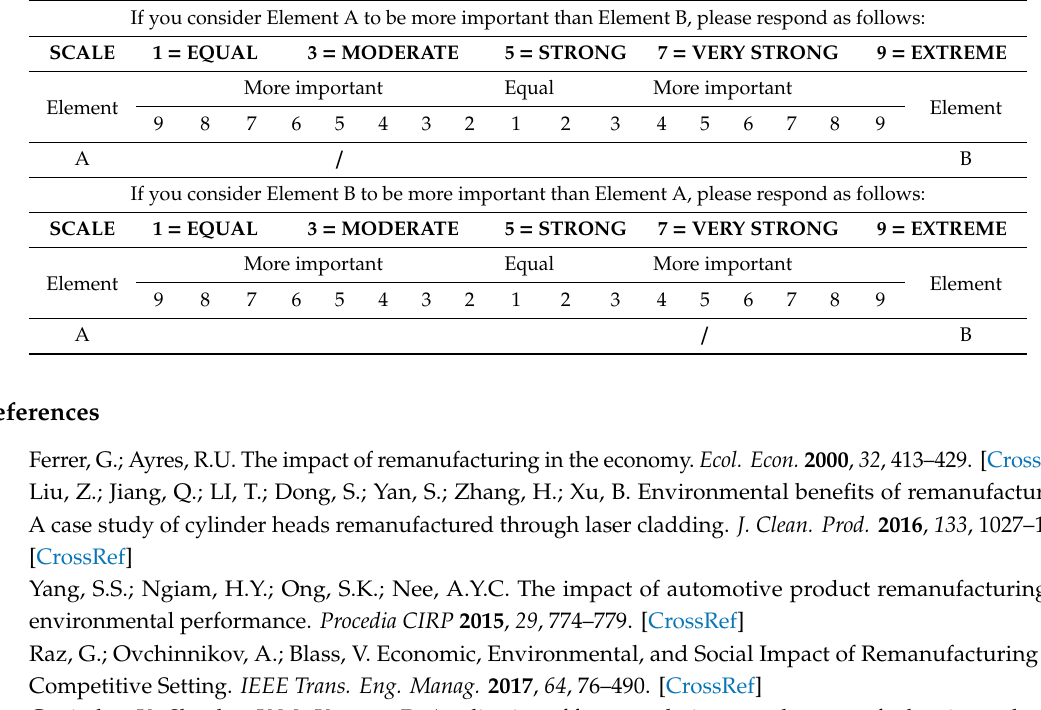
Table A1. Respondent guideline in pairwise comparison